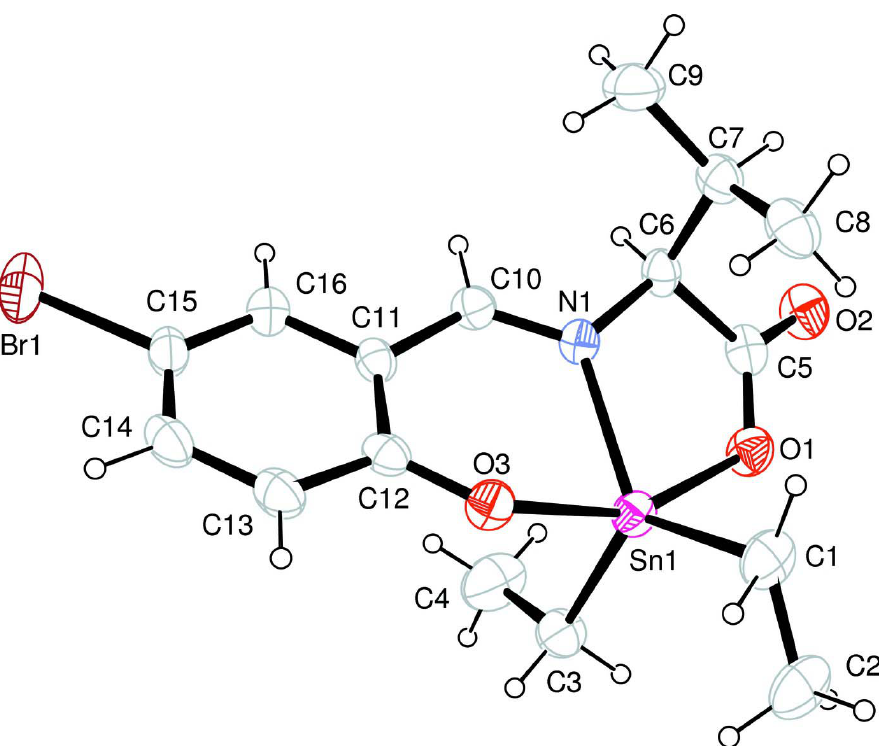
Figure 1 The molecular structure of (I) with displacement ellipsoids drawn at the 30% probability level. For C2 atom of ethyl group, the minor disordered component has been omitted for